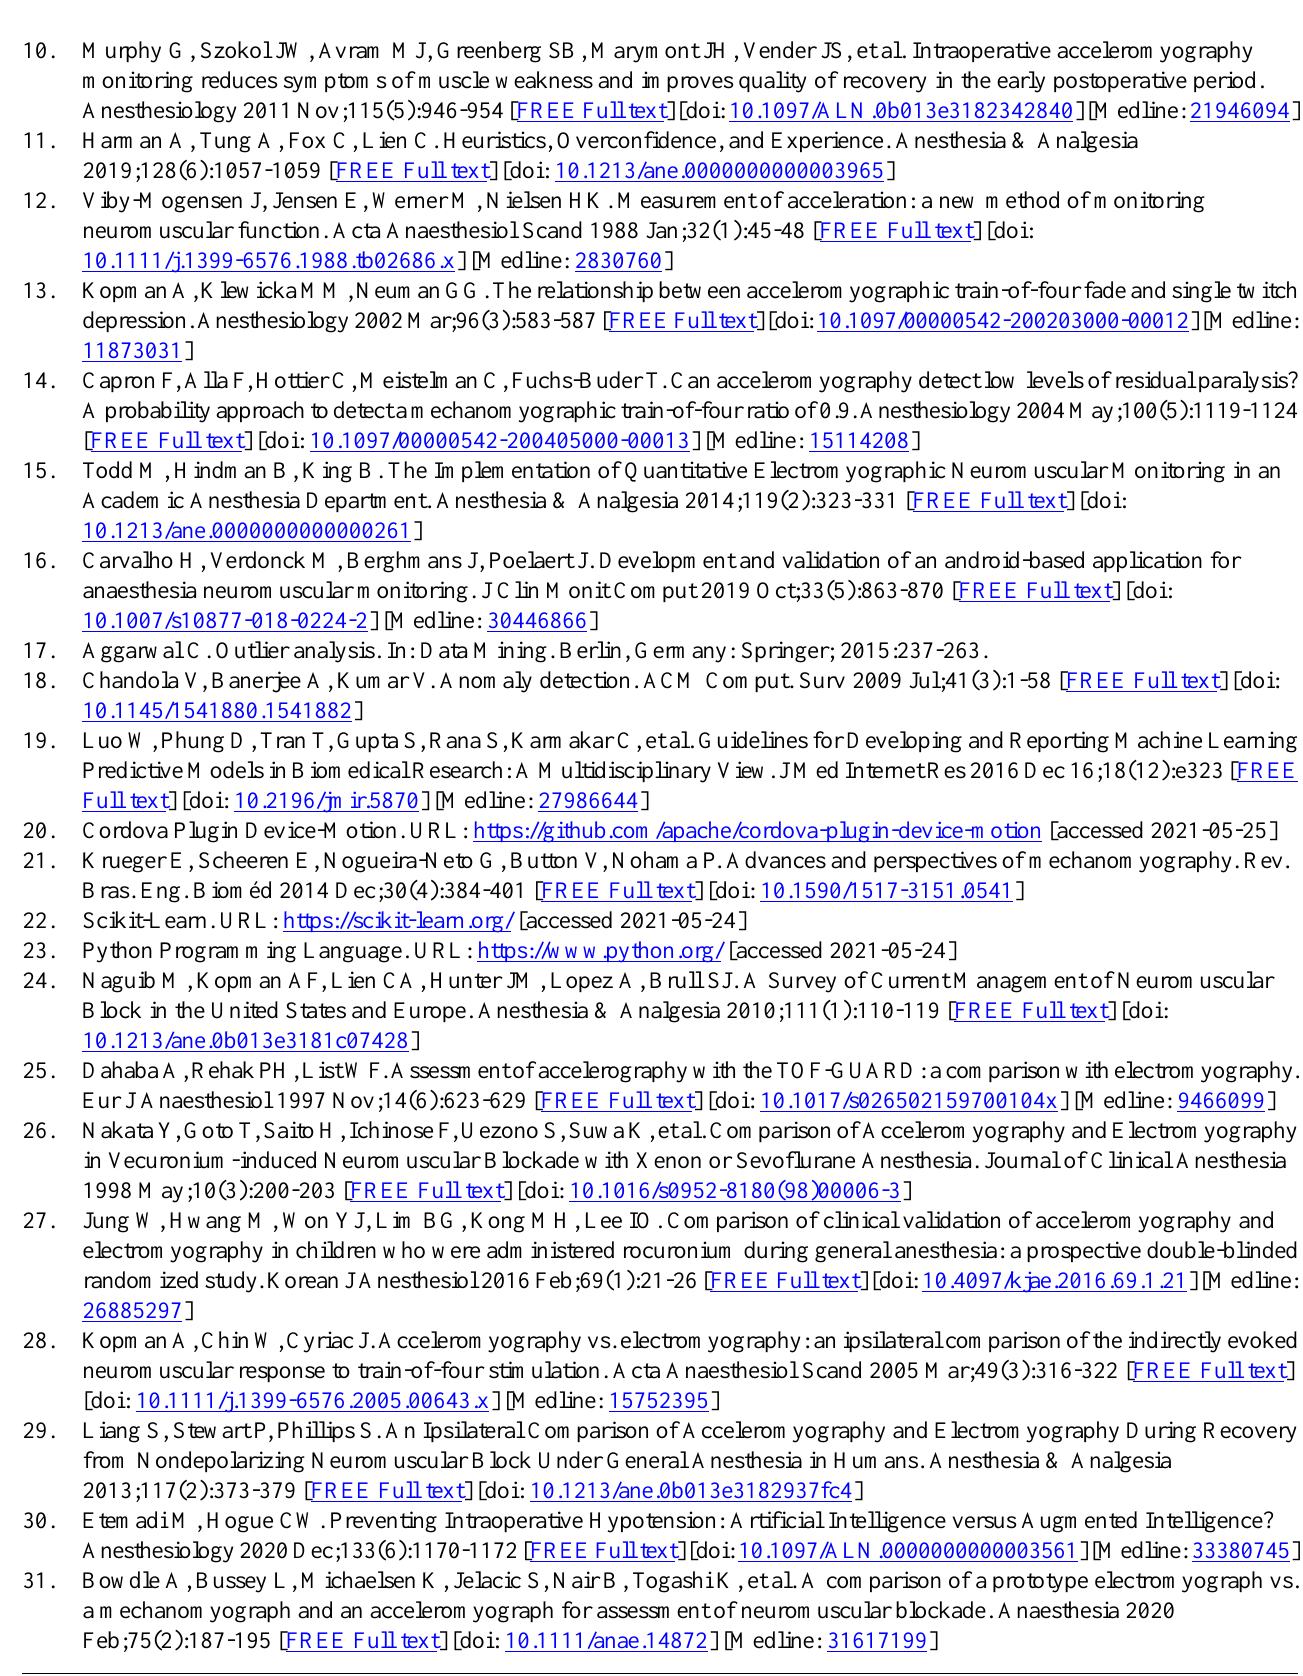
AMG: acceleromyography AUC: area under the curve